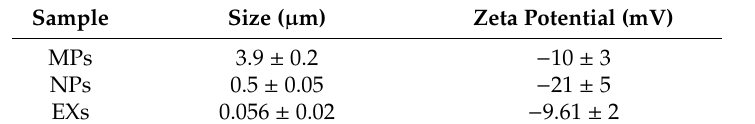
Table 2. Dynamic light scattering (DLS) particle measurement.